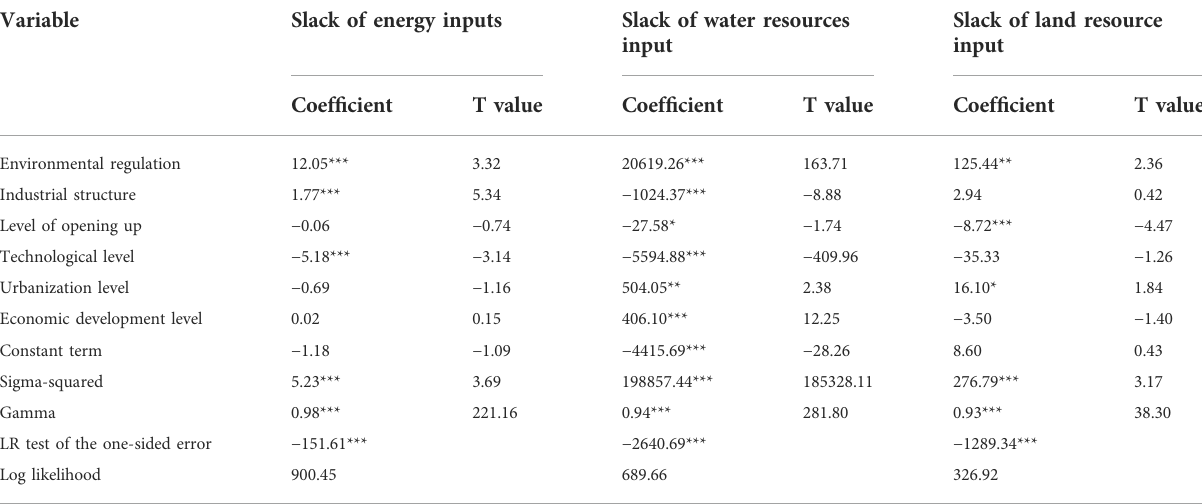
TABLE 4 Results of SFA regression in the second